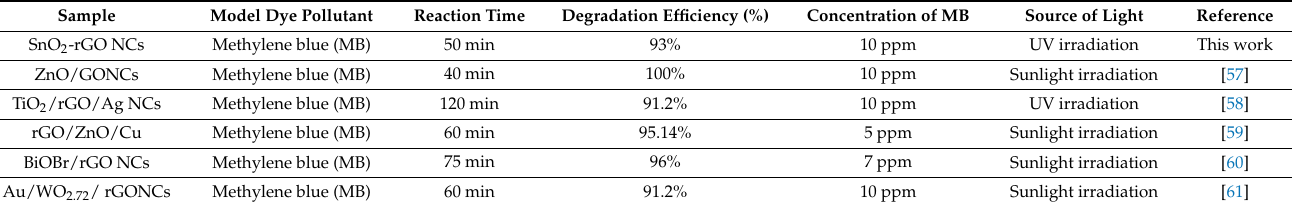
Table 2. Comparison of the MB dye degradation efficiency of the present samples with previous studies.